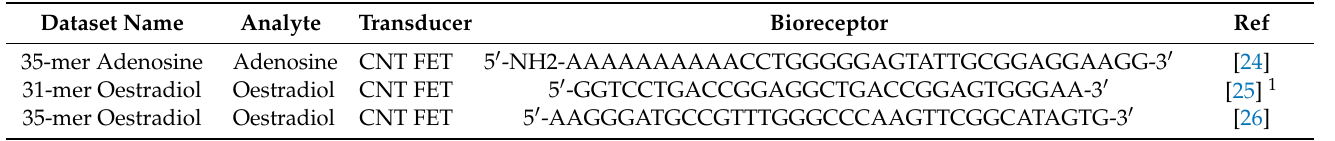
Table 1. The datasets and the main components of the sensors that recorded the signals in each